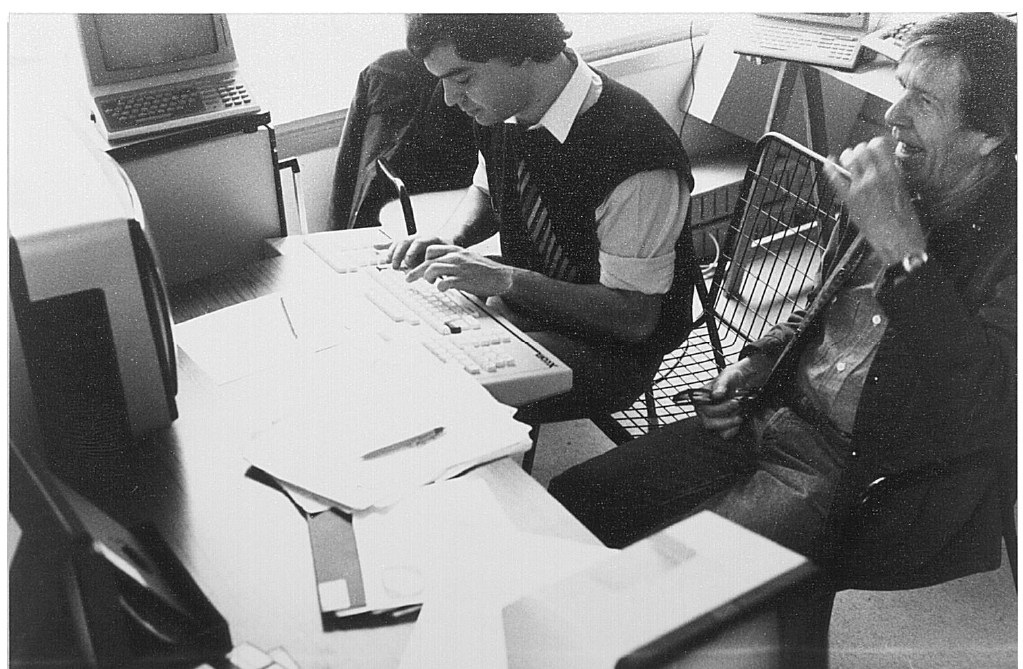
Figure 3. John Cage and the technician of Art Acc è s using a composition keyboard to create the screen pages of Cage’s project “Two Ackus”. Collection Fr é d é ric Develay © Kandinsky Library, MNAM/CCI, Centre